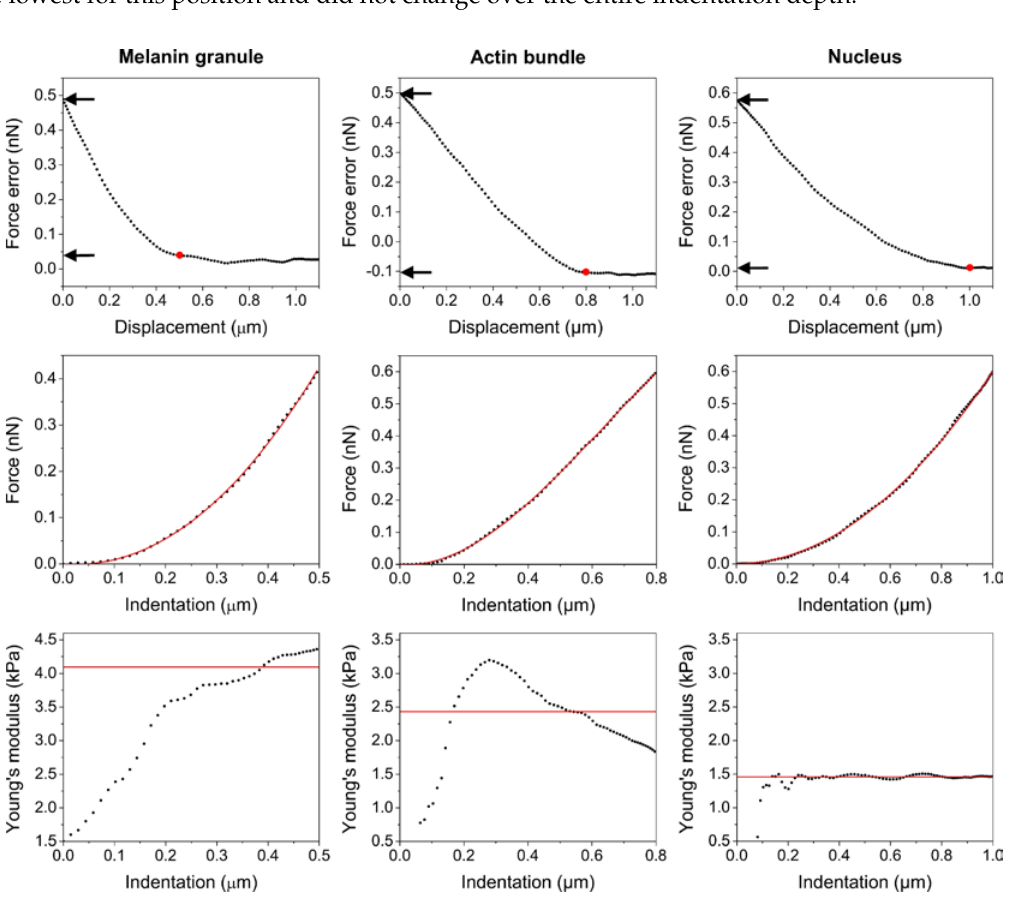
Figure 6. Representative force curves pulled from elasticity map for three different locations on the cell. Force error–displacement curves ( upper row ), followed by force–indentation curves ( middle row ) and Young’s modulus–indention curves ( bottom row ). Red dots in force error–displacement curves represent the point of contact of the AFM tip with the cell. Arrows point to the values of force on the y axis, which correspond to both minimum force (contact point) and maximum force (last point on the curve). Red lines in force–indentation curves represent fit of the theoretical model to the data points. Solid lines in pointwise modulus data represent the average values of the Young’s modulus calculated for each position. Note that the indentation depth differs significantly between the positions. It is lowest for a melanin granule and highest for the nucleus.